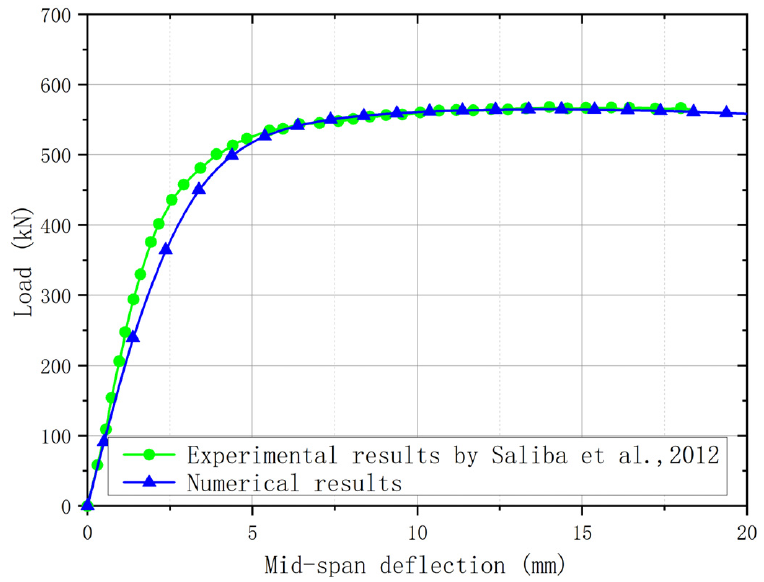
Figure 6. Comparison between experimental [31] and numerical results for plate girder under low-moment high-shear loading.